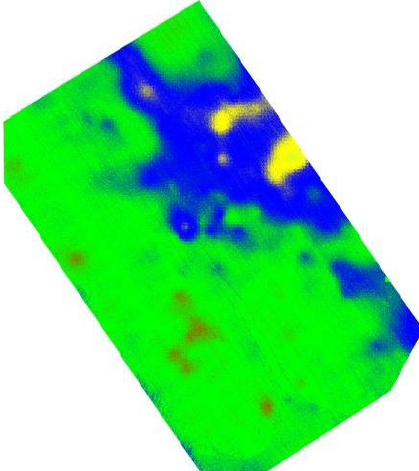
Figure 7. Classification of ER and NDVI maps and crop growth map with